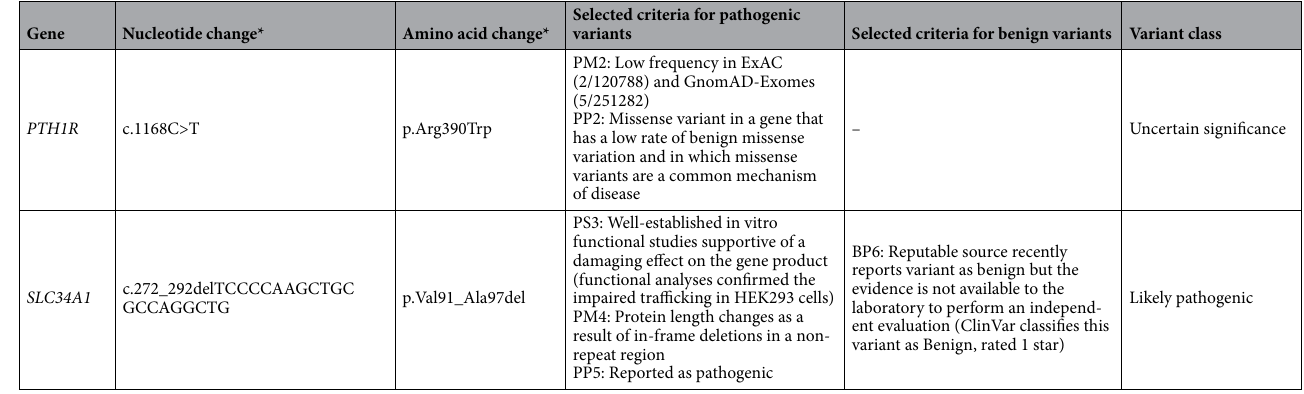
Table 3. Classification of PTH1R and SLC34A1 variants according to the ACMG guidelines. * Numbering is according to DNA sequence (Ensembl: ENST00000449590.6 for the PTH1R gene and Ensembl: ENST00000324417.5 for the SLC34A1 gene), all in heterozygous; PS, Strong evidence of pathogenicity; PM, Moderate evidence of pathogenicity; PP, Supporting evidence of pathogenicity; BP, Supporting evidence of benign